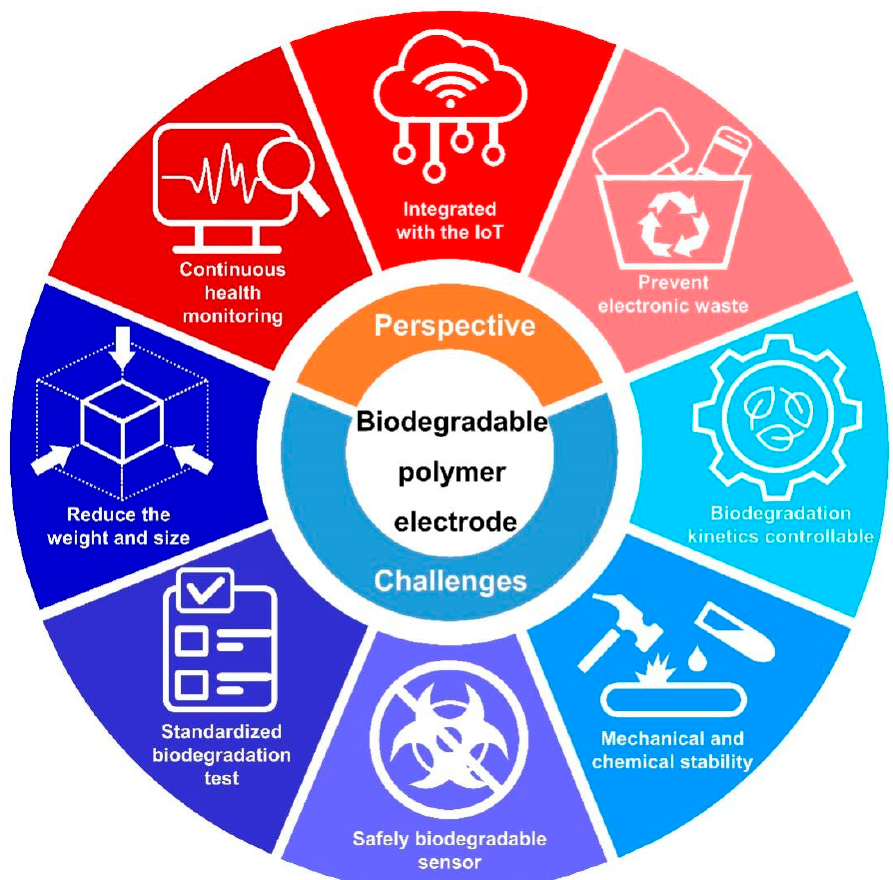
Figure 9. Overall schematic description of future perspectives and challenges for biodegradable polymer electrodes.